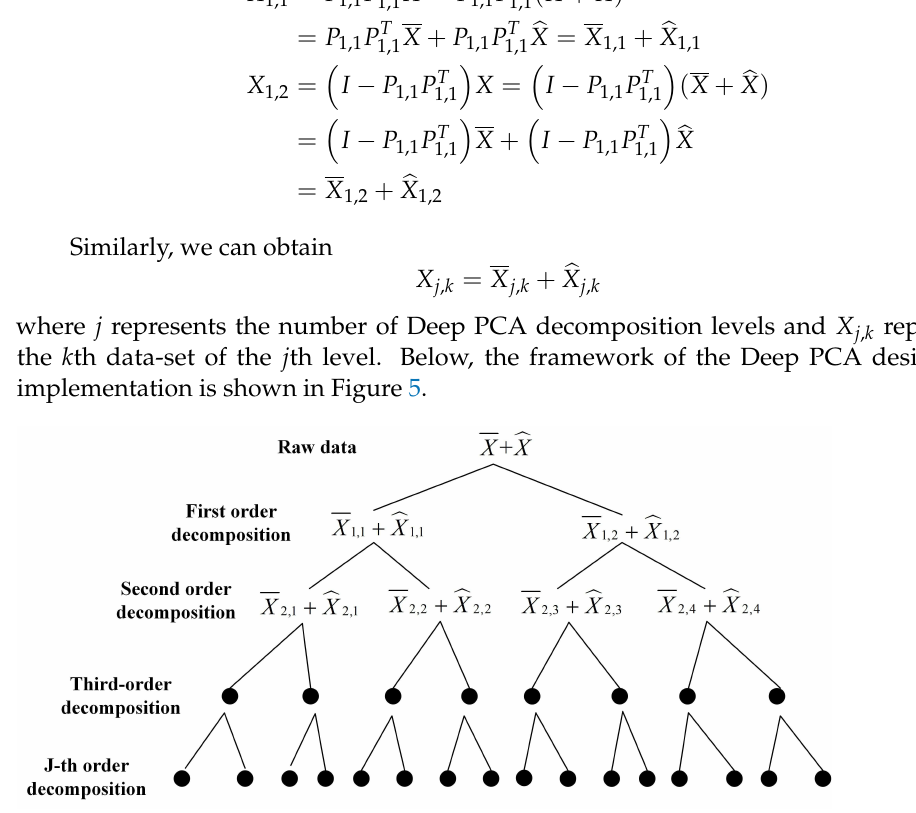
Figure 5. Framework of